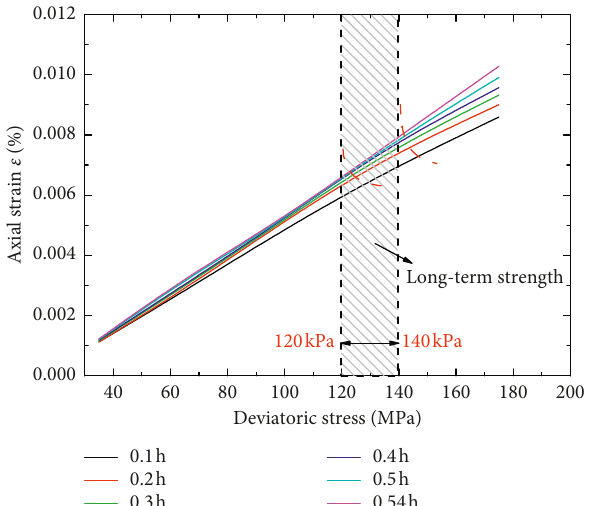
Figure 8: Experimental data and theoretical cuve ( σ � 175 MPa, T � 600 °